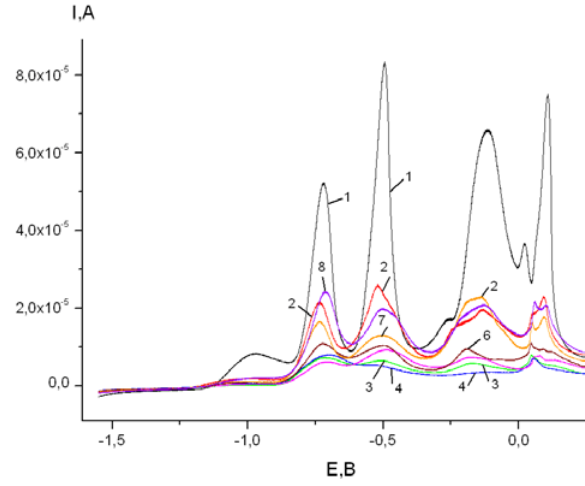
Fig.1. Stripping voltammograms of the test system with Betoftan in different concentrations: ( 1 ) test system; ( 2 ) lacrimal fluid of healthy people; ( 3 ) 4 × 10–3% of Betoftan; ( 4 ) 3 × 10–3% of Betoftan; ( 5 ) 2 × 10–3% of Betoftan; ( 6 ) 1 × 10– 3% of Betoftan; ( 7 ) 0.5 × 10–3% of Betoftan; ( 8 ) 0.1 × 10–3% of